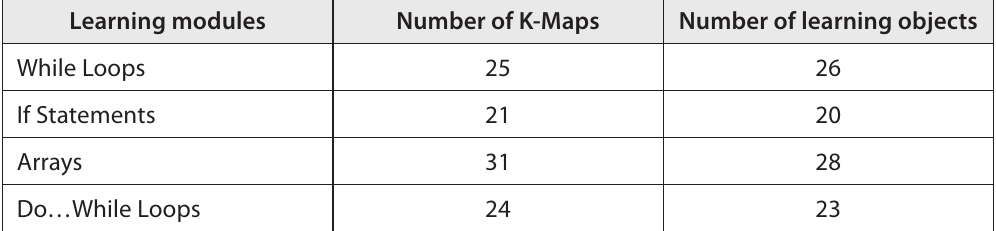
Learning modules